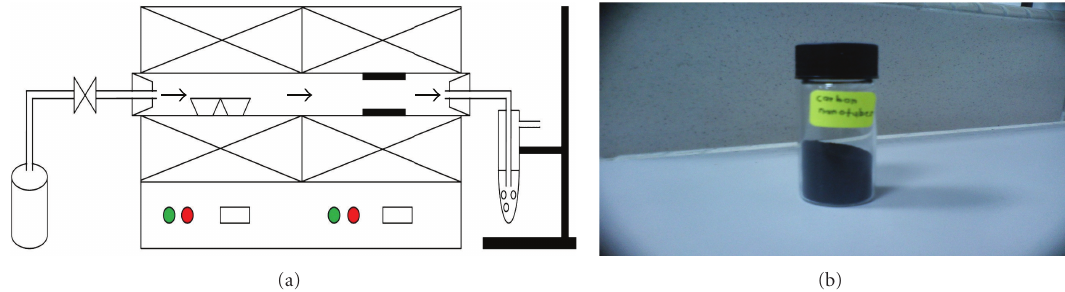
Figure 1: (a) Conceptual drawing of two-stage catalytic CVD and (b) optical photograph of CNT inside the